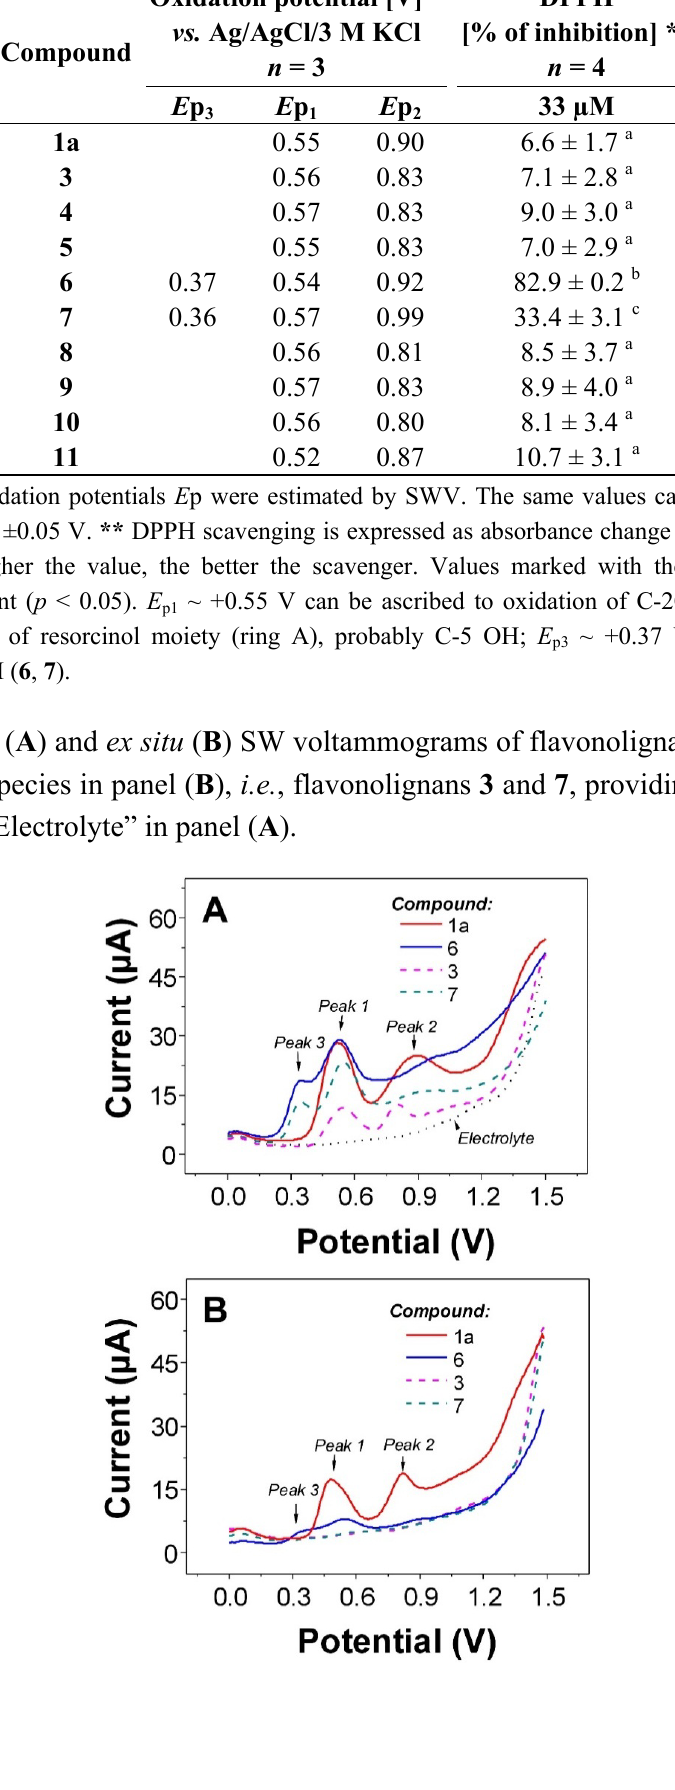
Table 1. Oxidation potentials ( E ( 1a , 6 ) and their dimers at pH 7.4.